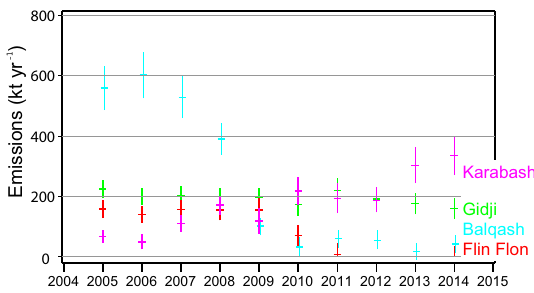
Figure 6. Estimated annual emissions from four smelters, with 2 σ error bars: Karabash, Russia; Gidji, Australia; Balqash, Kazakhstan; and Flin Flon, Canada. Note that emissions from Balkhash smelter have been reduced substantially after 2008 when a sulfuric acid fac- tory started to utilize emitted SO 2 . The operation of the Flin Flon copper and zinc smelter was stopped in